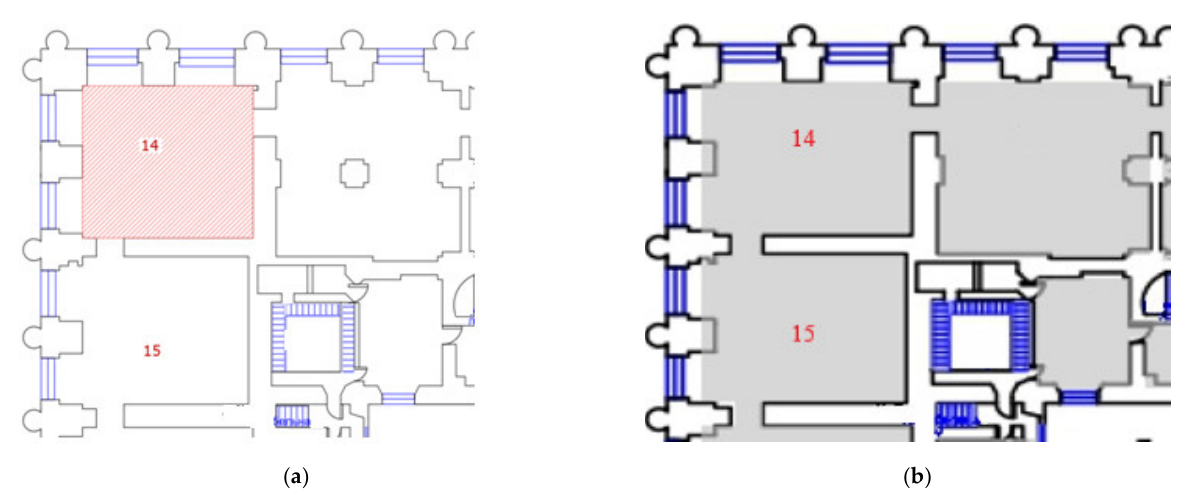
Figure 5. Columns in the Jordan Gallery ( a ); Columns in the Jordan Gallery in the model ( b ). As a second simplification, window niches are excluded from the calculation area (they do not lie on the evacuation routes). The exclusion of window niches from the com- putational domain entails a reduction of the computational domain for simulating fire development (Figure 6).